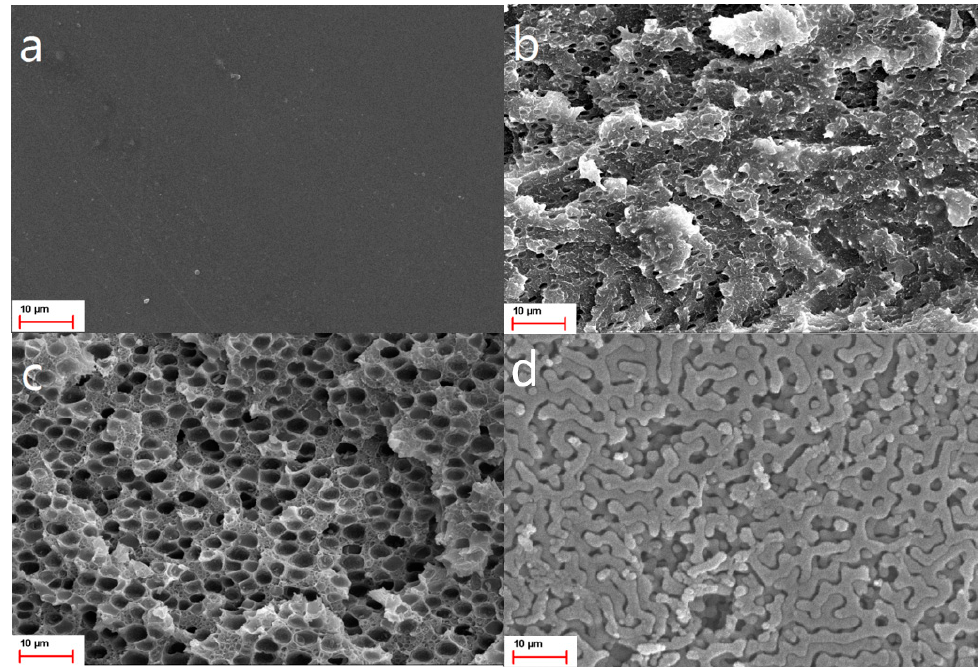
Figure 5. Cross-section SEM images of PI films from: a, PAA by reaction of PMDA and ODA with equal mole ratio; b, PAA I - b -PS; c, PAA II - b -PS; d, PAA III - b -PS.